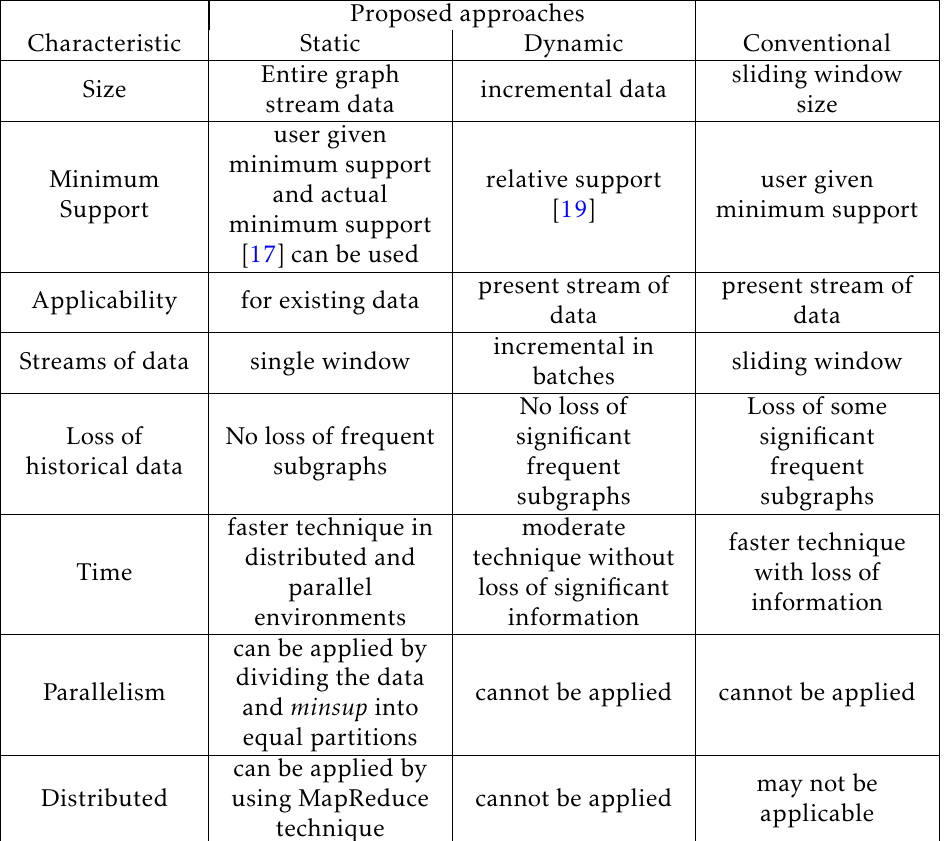
Table 9. Characteristics of Proposed Static and Dynamic Approaches compared to Conventional